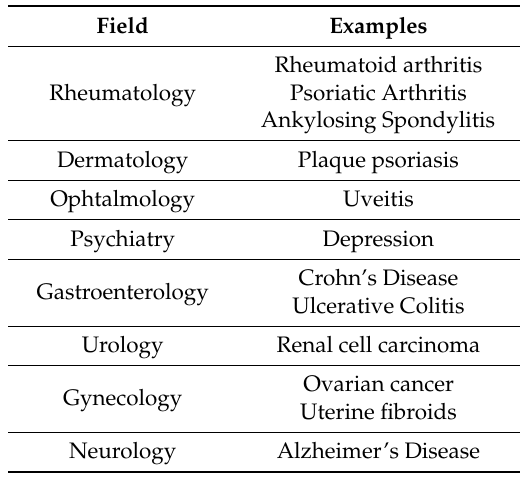
Table 1. Examples of human diseases with dysregulated TNF- α production